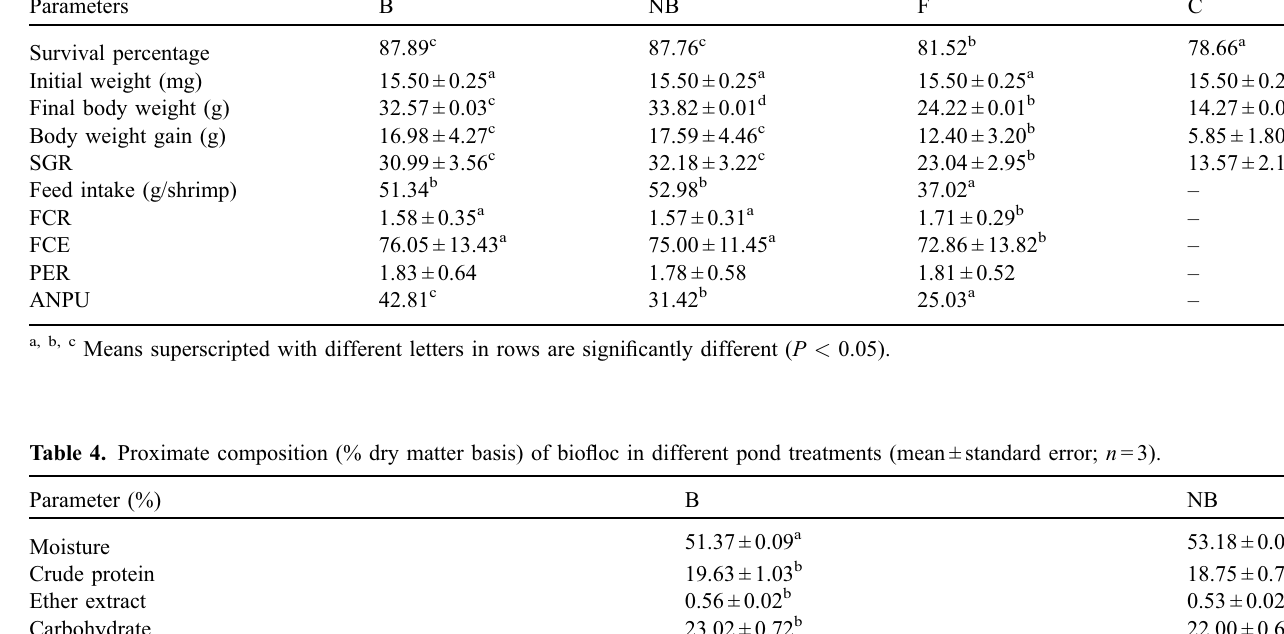
Table 3. Growth performance of L. vannamei in different pond treatments (mean ±standard error; n = 3). Parameters